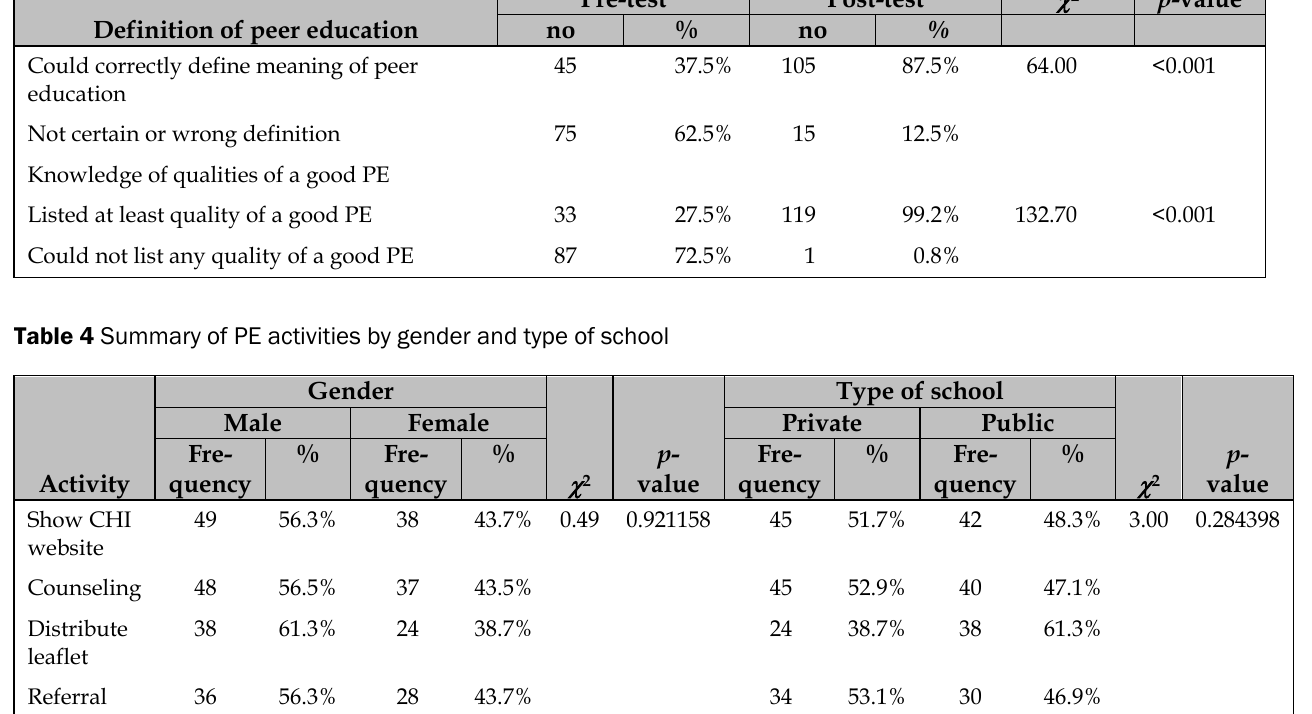
Table 3 Knowledge of definition and qualities of a good PE (n=120) Definition of peer education